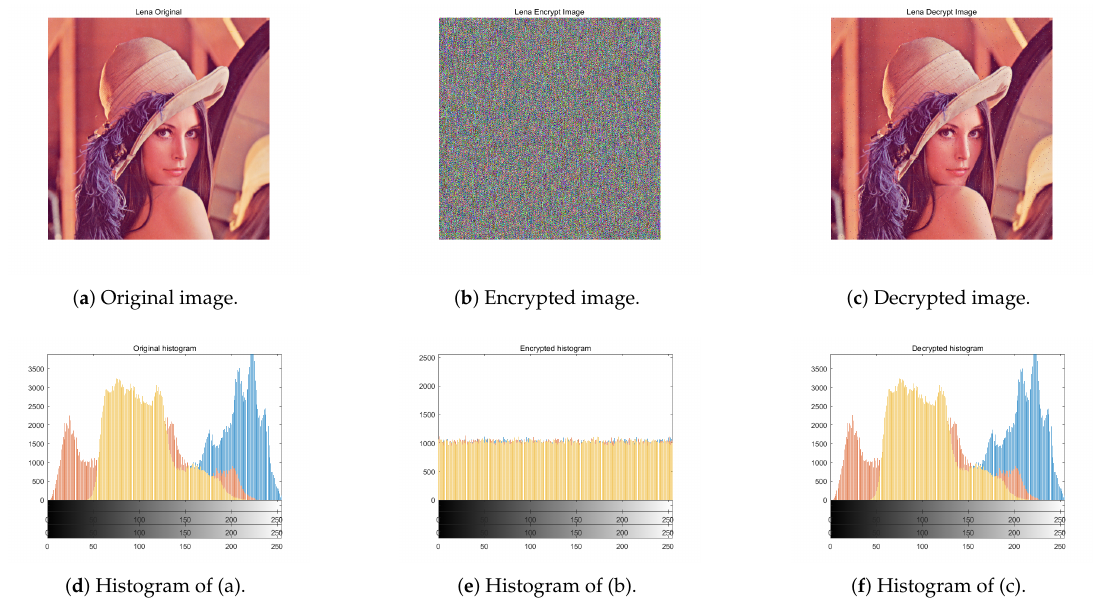
Figure 3. Encryption and decryption of “Lena.tiff.” after the system